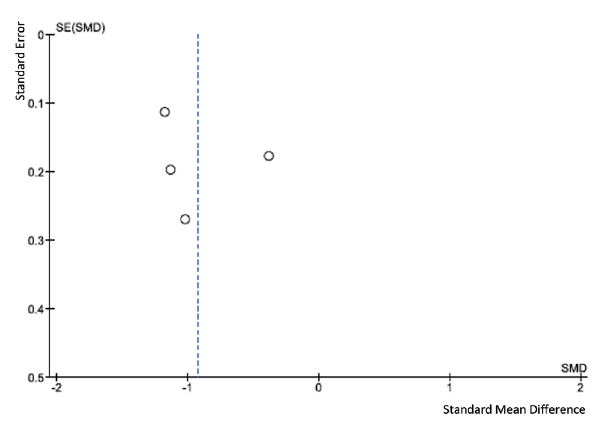
Figure 3. Funnel plot. Funnel plot showing study outcomes are not sym- metrical around the st.andard mean difference suggesting reporting bias is